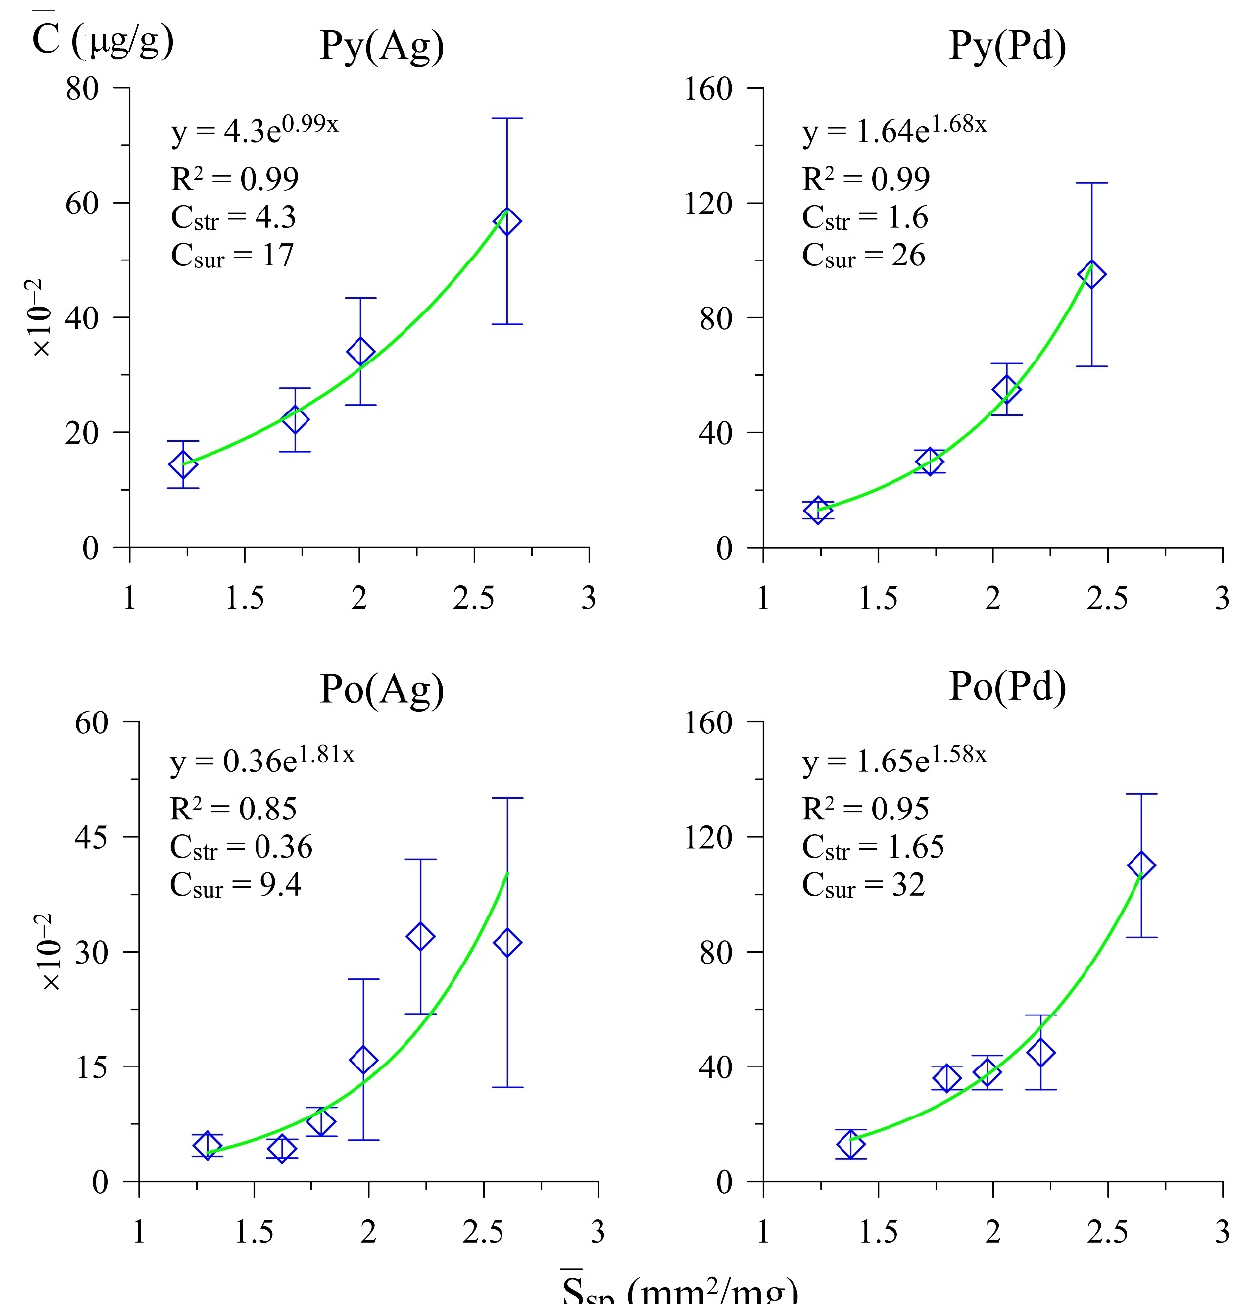
Figure 2. Dependence of the average concentrations of evenly distributed TEs in pyrite (Py) and pyrrhotite (Po) on the specific surface area of an average crystal of crystal-size fractions. The expres- sions for the approximate curves and concentrations of structurally and superficially bound modes are shown (see Table 1 for details).